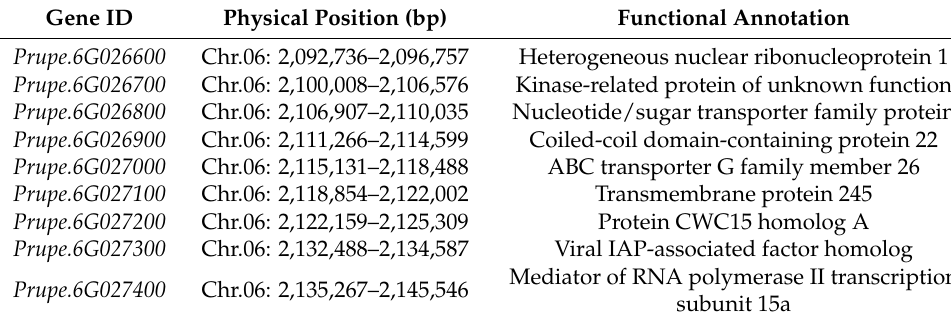
Figure 3. Genome-wide association study result of peach pollen fertility trait. The y -axis indicates the association value of the SNPs, and the x -axis indicates their positions on the chromosomes. The horizontal red line represents the significance threshold (7.32) for the association of peach pollen fertility trait. Table 1. Information pertaining to candidate genes for peach pollen